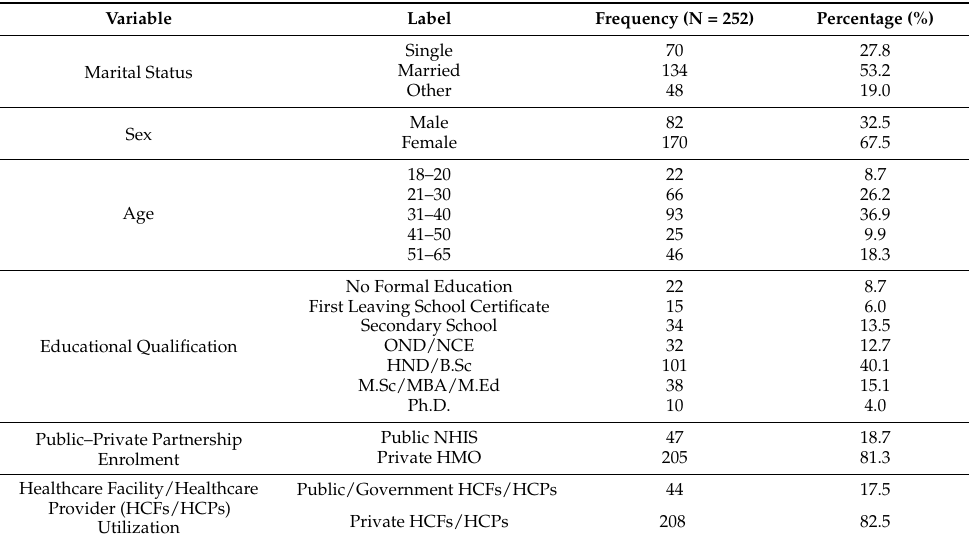
Table 1. Sociodemographic characteristics of